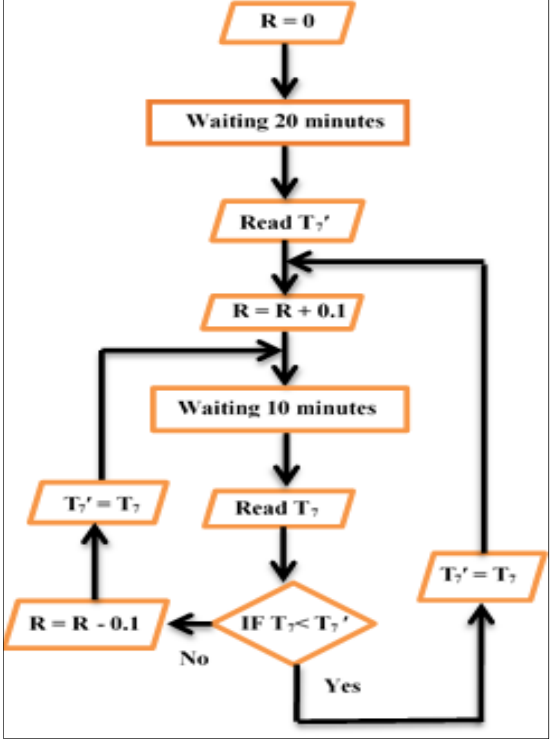
Fig. 7. Flow chart of the control program.